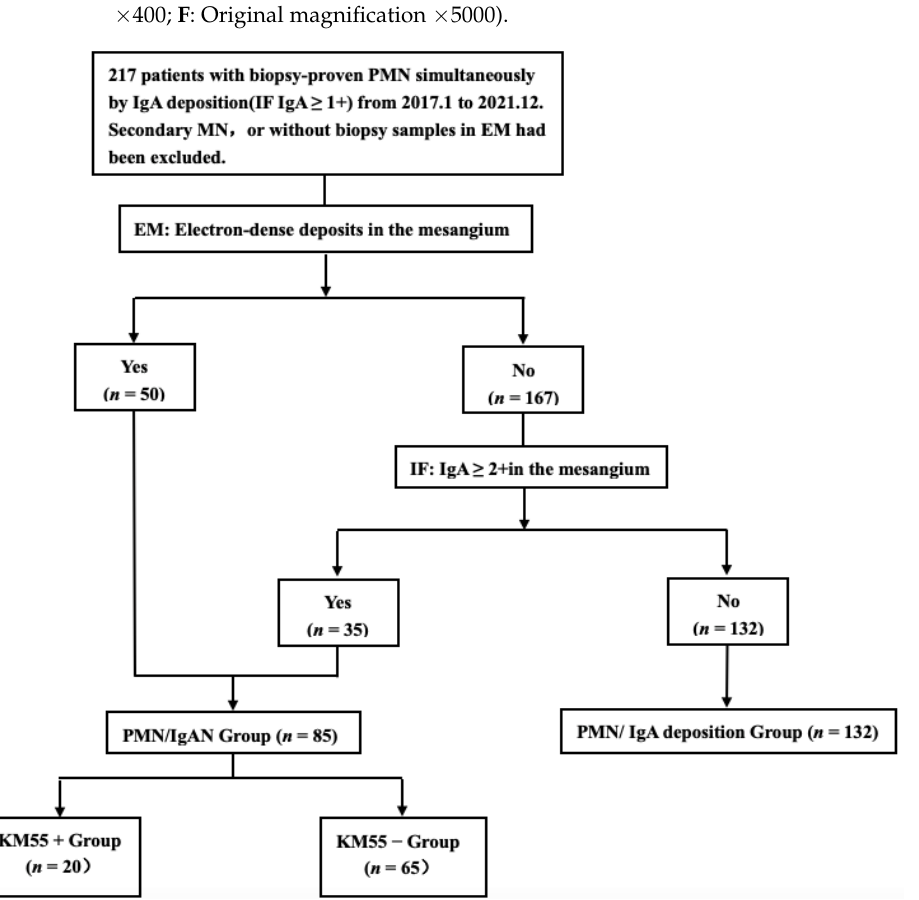
Figure 2. Flowchart of the recruitment